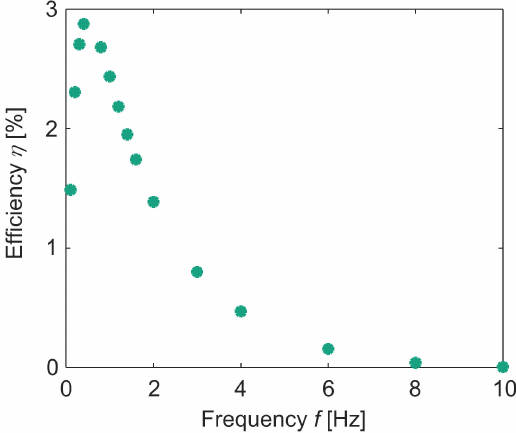
. Q max /2 in relation to the system frequency.